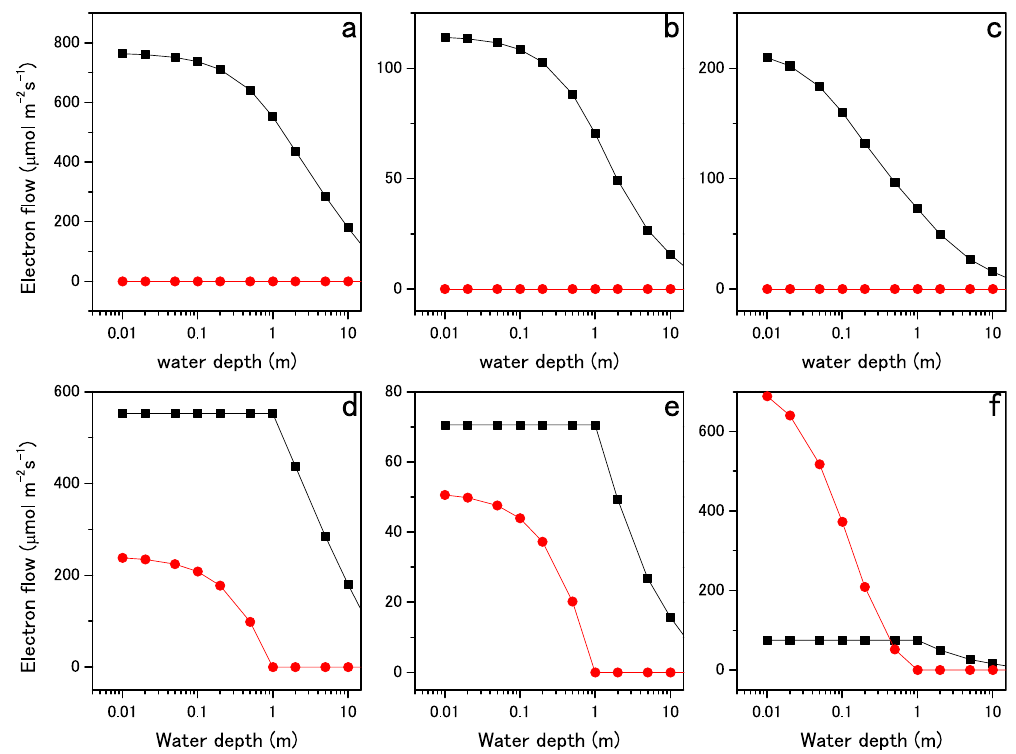
Figure 5. Regulation of the electron transfer reaction in shallow water. The changes in LEF (black squares) and CEF (red circles) as a result of state transitions are plotted as a function of water depth. Panels a–f correspond to panels a–f in Fig. 4. CEF and LEF were calculated from the antenna size and light